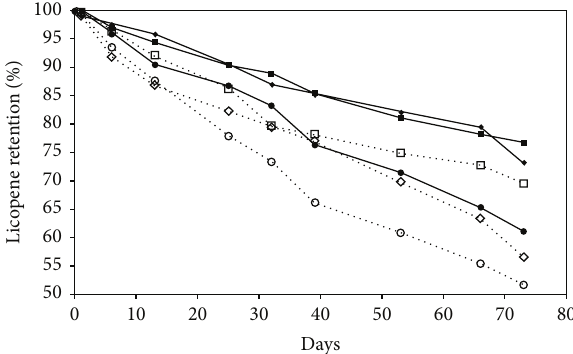
Figure 2: Storage stability of free and microencapsulated lycopene during storage at 10 ∘ C: ( ⧫ ) 1 (P2.5/R25) ( − 0,3391 𝑥 + 99,474/ 𝑅 2 = 0,9819), ( ◼ ) 6 (P5.0/R75) ( − 0,3242 𝑥 + 99,201/ 𝑅 2 = 0,9906), and ( e ) free lycopene ( − 0,5257 𝑥 + 99,297/ 𝑅 2 = 0,9922) and during storage at 25 ∘ C: ( ◊ ) 1 (P2.5/R25) ( − 0,5384 𝑥 + 97,236/ 𝑅 2 = 0,9796), ( ◻ ) 6 (P5.0/R75) ( − 0,4203 𝑥 + 97,947/ 𝑅 2 = 0,9505), and ( I ) free lycopene ( − 0,666 𝑥 + 97,194/ 𝑅 2 =